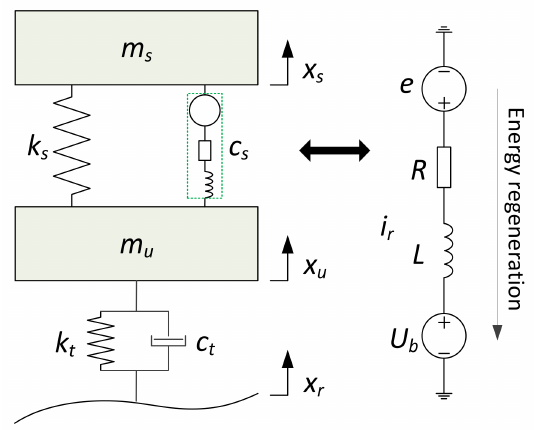
Figure 1. One-quarter suspension